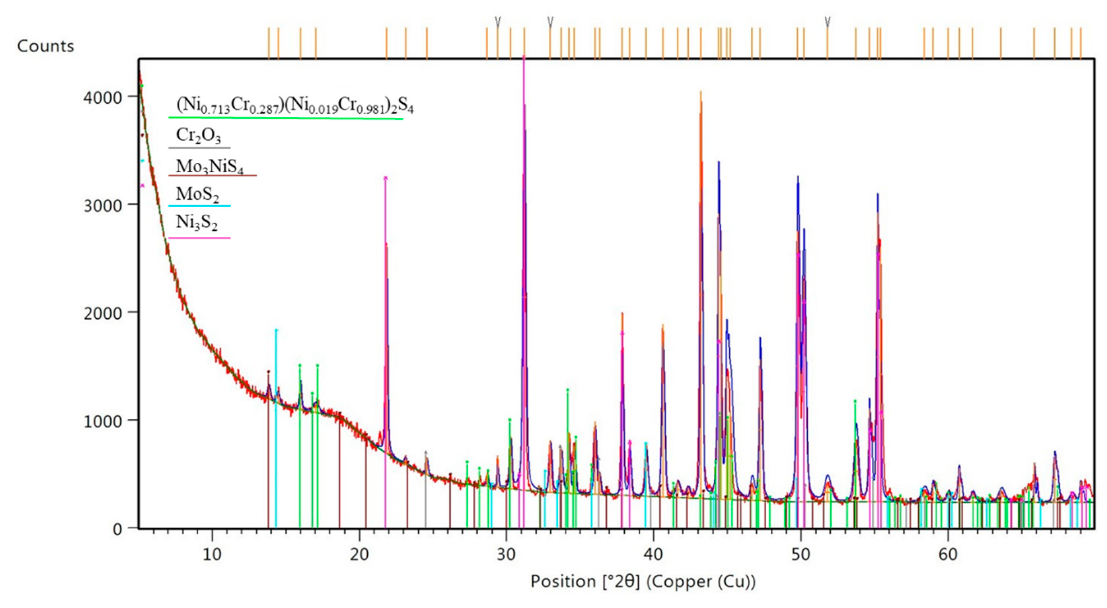
Figure 6. XRD diffraction pattern of corrosion products formed on N10276.